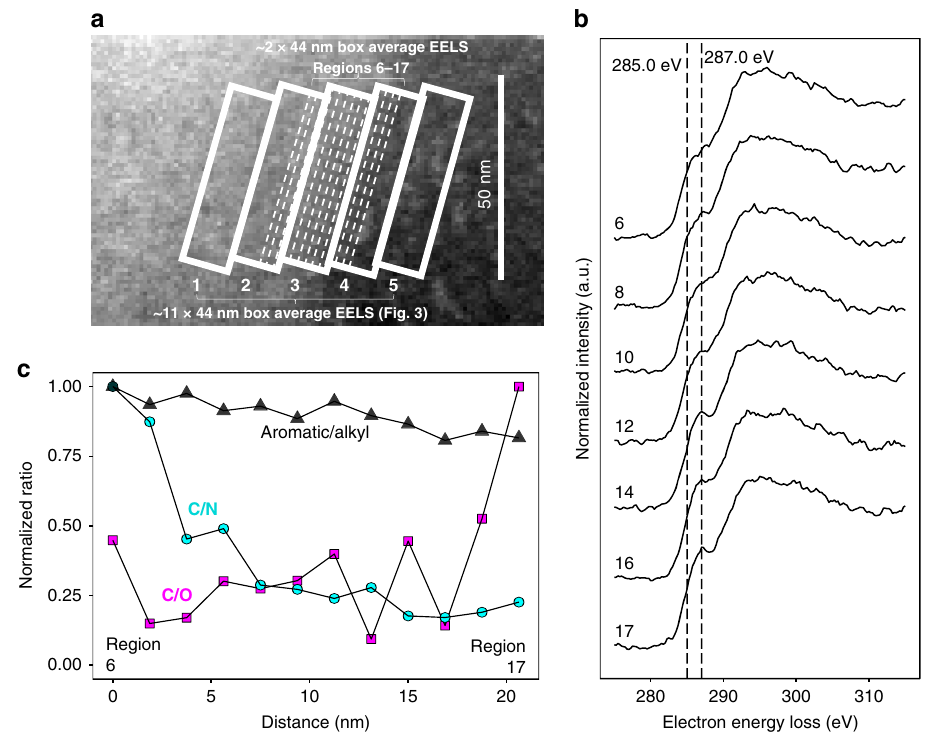
Fig. 5 High-resolution characterization of the organo – organic interface. Organo – organic interface characterization at 2-nm lateral resolution shows variations in organic matter composition at 5 – 11 nm distances. a Overview annular dark- fi eld (ADF) STEM image showing approximate locations of 2 × 44 nm analysis regions (white dashed lines, labeled 6 through 17) across the interface, within 11 × 44 nm box analysis regions (1 through 5) (also shown in Fig. 4). b Average (2 × 44 nm boxes, ~90 individual spectra per box) electron energy-loss (EEL) spectra (normalized to maximum = 1), with vertical dashed lines at 285.0 and 287.0 eV, putatively associated with aromatic and alkyl C, respectively. c Aromatic/alkyl C, C/N, and C/O signal intensity ratios across the interface show fl uctuations at <5 nm distances for aromatic/alkyl C ratios and <11 nm distances for C/N and C/O ratios, consistent with a layered gradient in OM